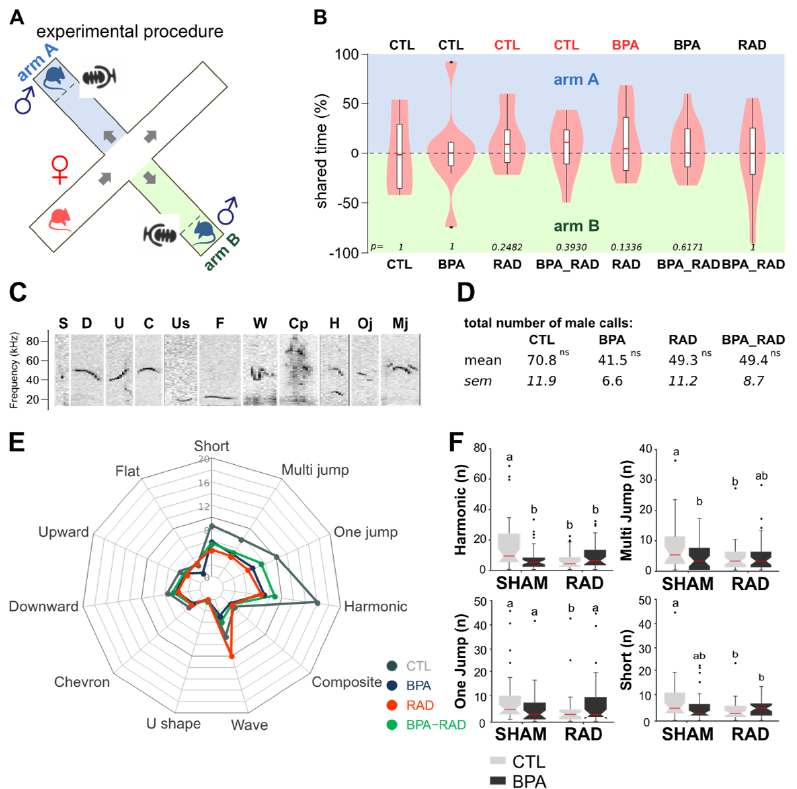
Figure 6. RAD exposure in utero alters the emission of male mouse ultrasonic vocalizations during courtship. ( A ) Schematic diagram of the partner preference test design. A sexually receptive free- moving female was placed in an arm of the X-maze. Two adult males from each experimental group (CTL, BPA, RAD, BPA_RAD) were caged in one arm, and the time spent in each arm was measured. At the same time, male ultrasonic vocalizations (USVs) were recorded by microphones placed close to the males. ( B ) Violin plot of the female time spent in the two arms (% of time spent in arm A minus % of time spent in arm B, chi-square test, n = 5–7). ( C ) Typical spectrograms illustrating eleven distinct call categories. ( D ) Total number of USVs emitted by control (CTL), BPA and/or RAD exposed adult mice (data are expressed as the means ± sem, no statistically significant difference was observed after two-way ANOVA). ( E ) Radar chart of the total number of syllables emitted by control (CTL)–, BPA– and/or RAD-exposed adult mice (data are expressed as the means). ( F ) Notched box plot of the total number of harmonic one-jump, multiple jump and short calls. Different letters indicate significant differences between groups (two-Way ANOVA, Tukey’s multiple comparisons test, p < 0.05, n =